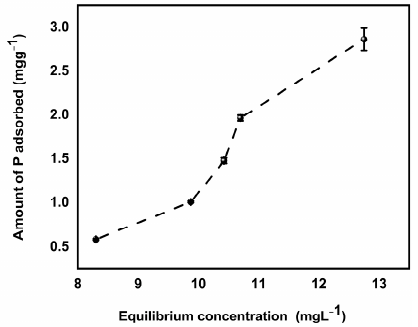
Figure 9. P retention of soil/Douglas fir biochar treated with MgCl 2 · 6H 2 O + KOH solutions (MKB) mixture. (Values shown are mean of n = 3, error bars shown as standard deviation).